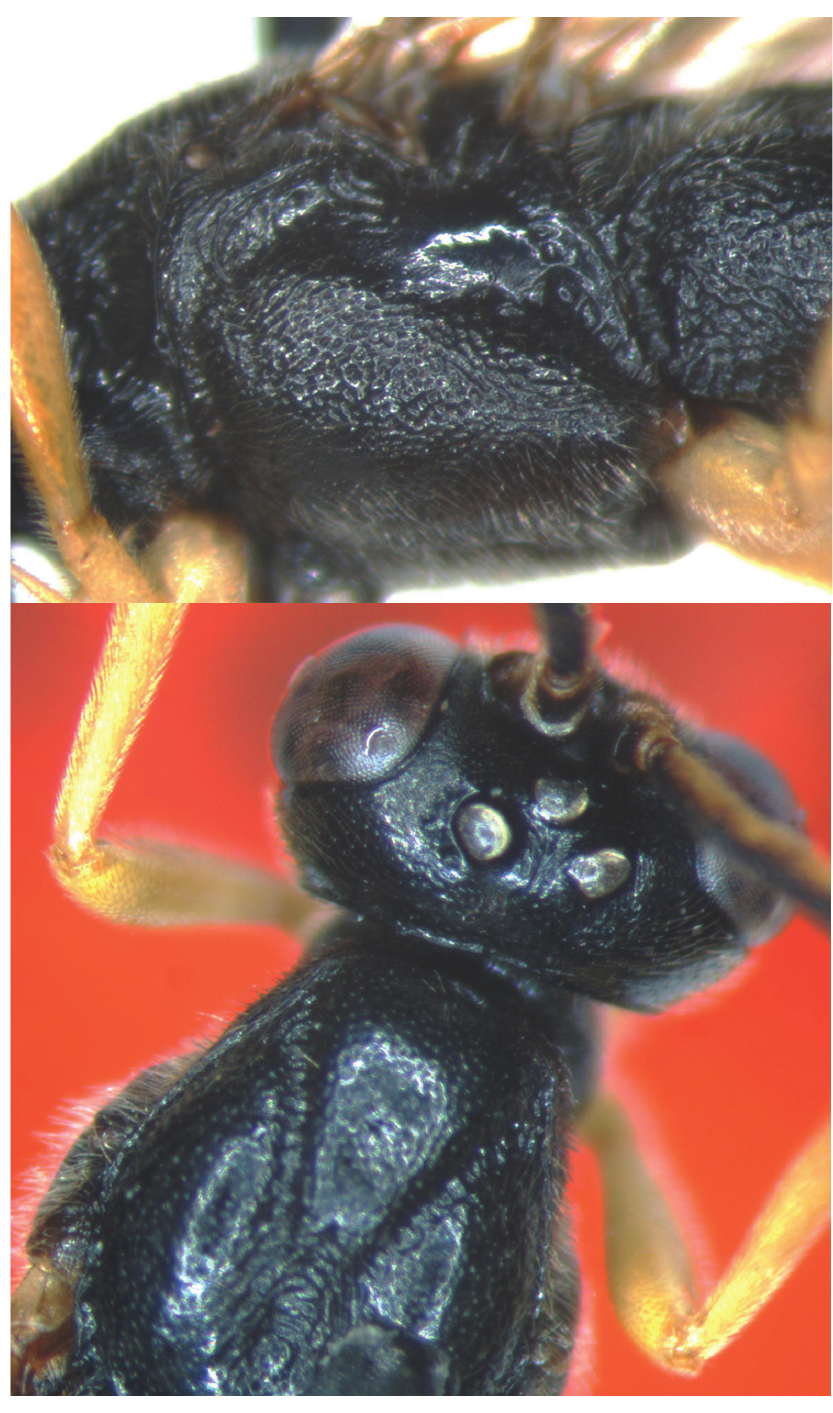
Figure 11. Mesopleuron a and mesoscutum b of Bicurta sinica